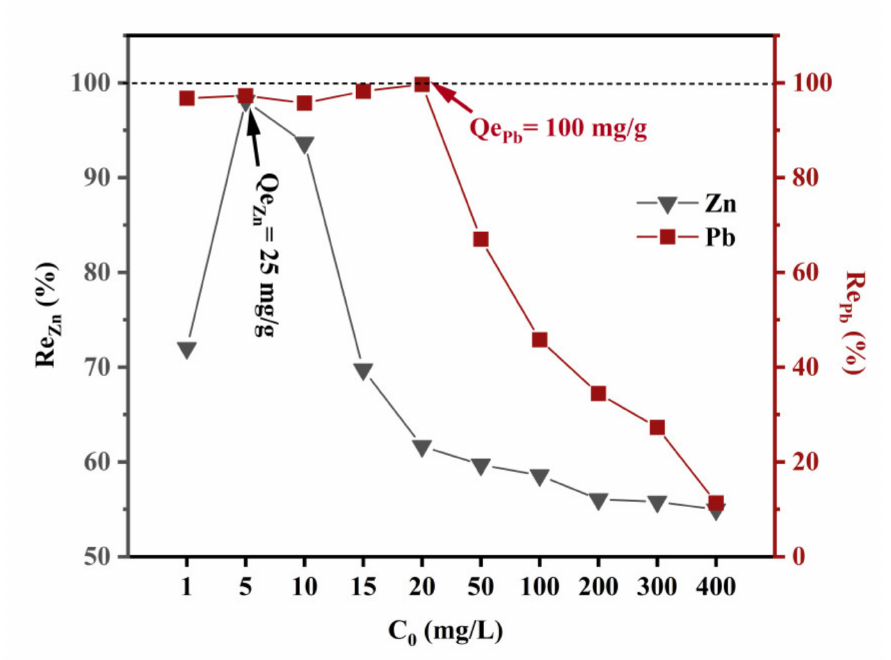
Figure 10. Removal efficiencies of Zn and Pb from aqueous solution by sulfidation product (reaction conditions: solid-to-liquid ratio 0.2 g/L, 25 ◦ C, 6